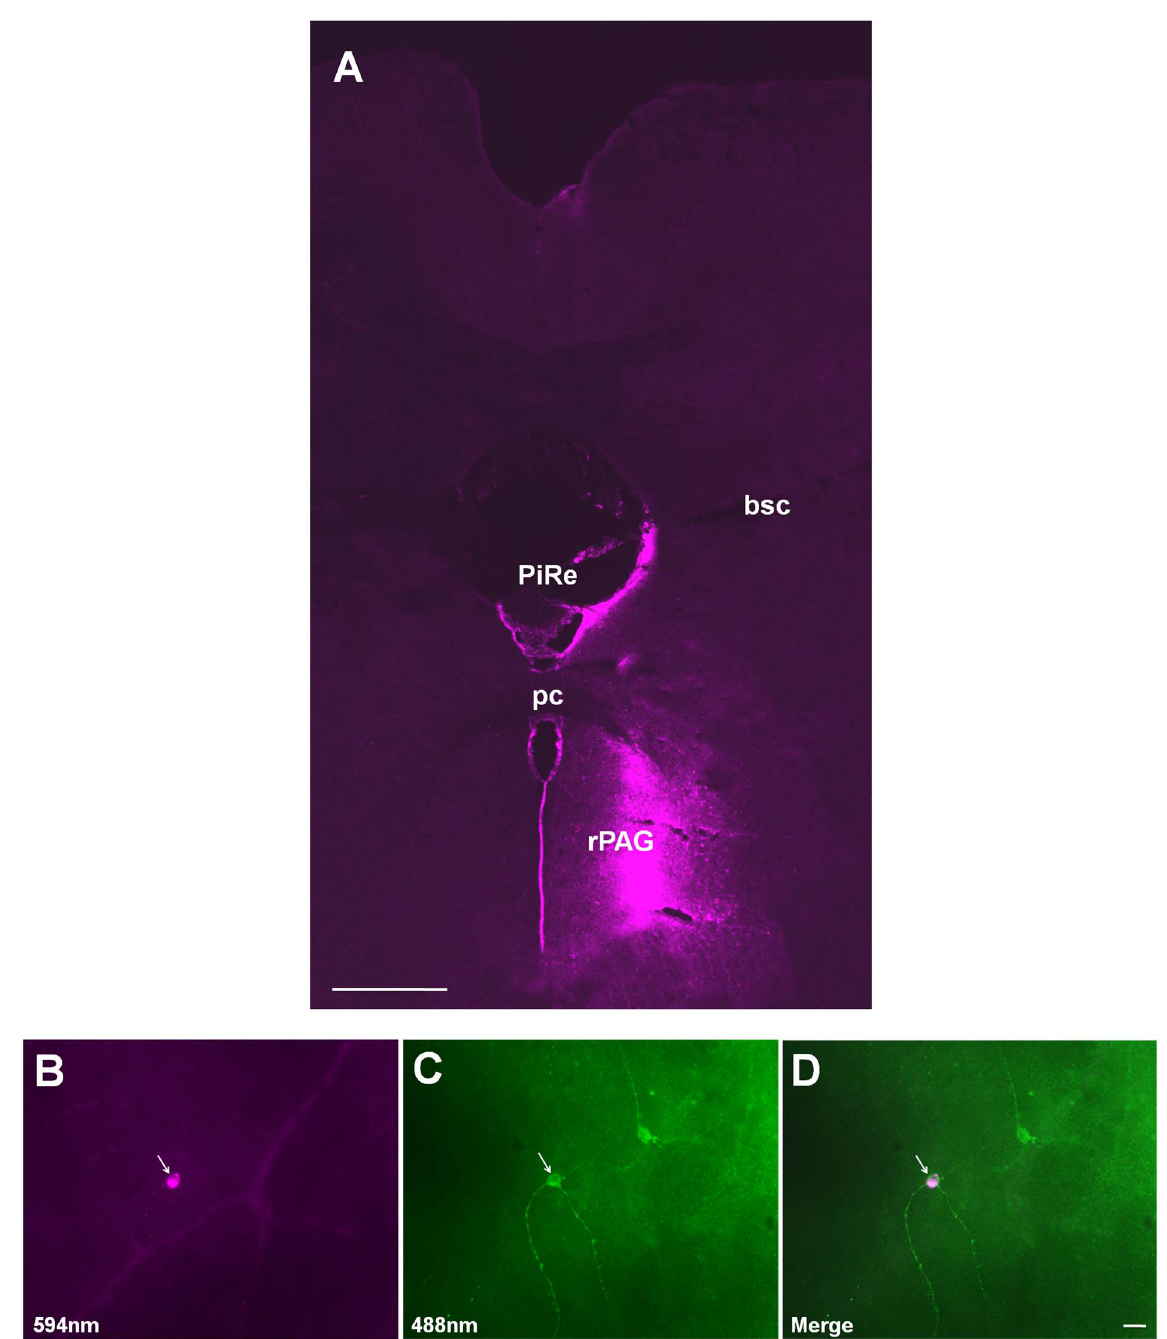
Figure 3. Innervation of melanopsin-expressing retinal ganglion cells (mRGCs) in the rostral periaqueductal gray (rPAG). (A) Coronal section of an injection site. (B–D) Arrow points to a CTB retrogradely labeled rPAG-projecting RGC. This cell was also positive for melanopsin immunoreactivity (C), but not all mRGCs could be retrogradely labeled by CTB (arrowhead in C and D). bsc: the brachium of the superior colliculus; PiRe: pineal recess; pc: posterior commissure; rPAG: the rostral periaqueductal gray. Scale bars: 300 m m in A; 20 m m in D (applies to B and